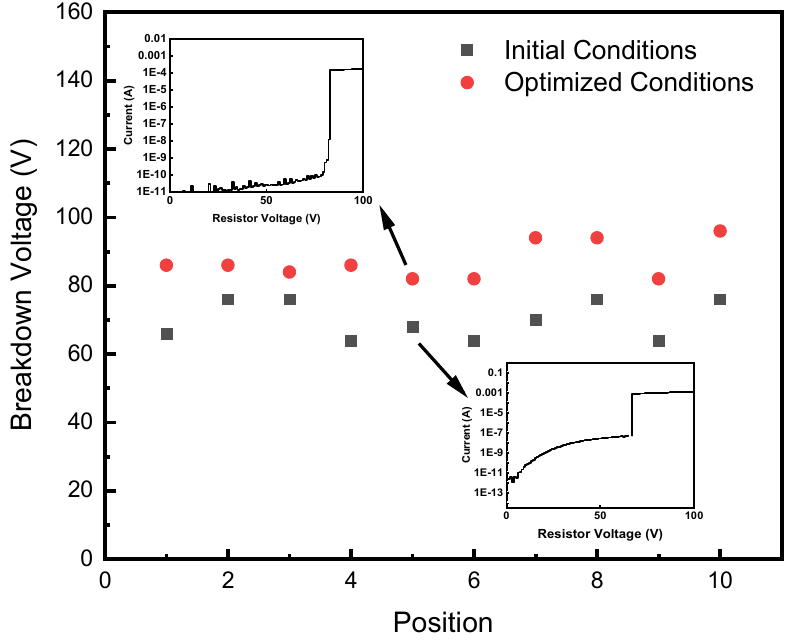
Figure 12. Breakdown voltage at various test locations under two conditions.